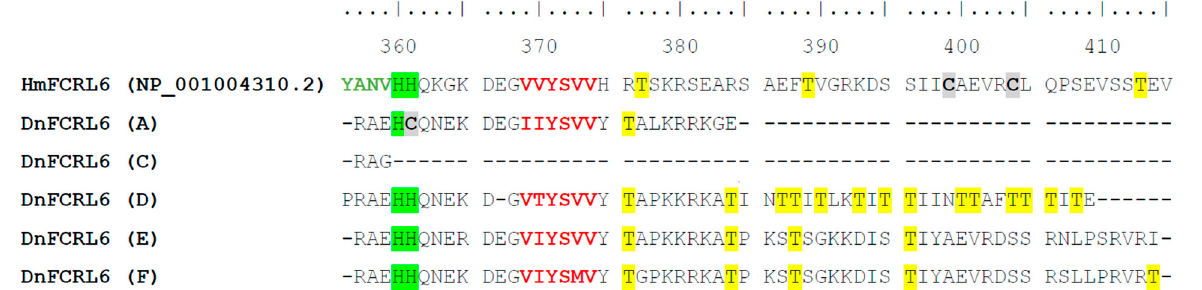
Figure 4. Multiple sequence alignment of the human and nine-band armadillo FCRL6 cytoplasmic tails. Marked are potential tyrosine-based activating and inhibitory sequences, along with cysteine, histidine and threonine residues. Alignment was performed using CLUSTALW in the BioEdit software package. An ITAM-like sequence ( H. sapiens ) is colored green and ITIM are red. Cysteines are in black, bold and highlighted grey. Histidine is highlighted green. Threonine is highlighted yellow. The number of extracellular cysteine residues present in the D. novemcinctus FCRL6